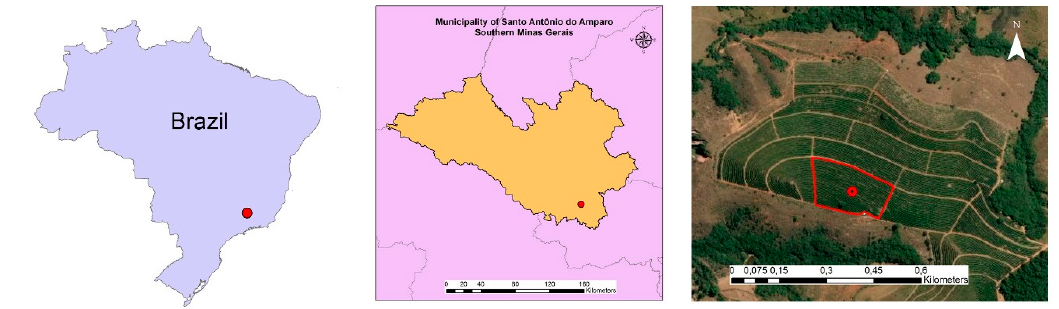
Figure 1. Farm location and field delimitation.